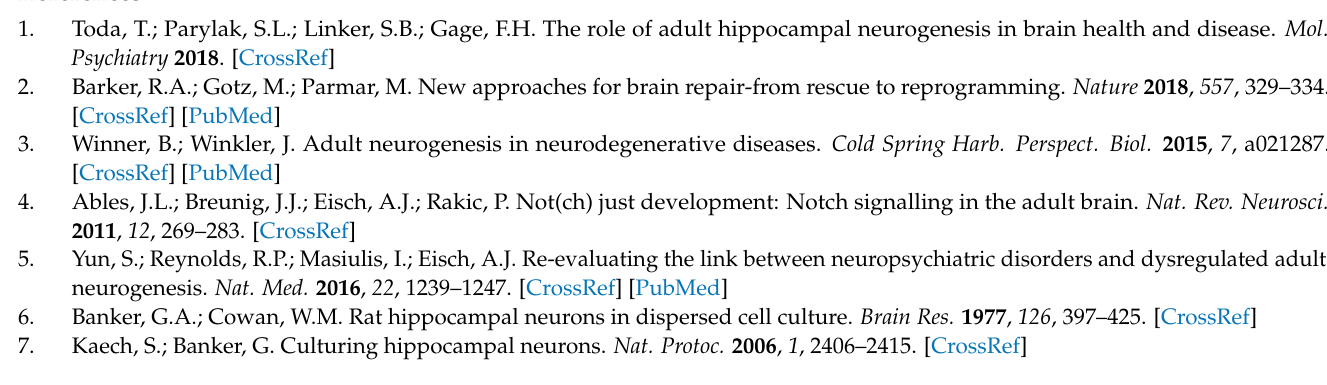
Figure S2; improvement of survival rate of NPC-iNs. Supplemental Figure S3, verification of experimental